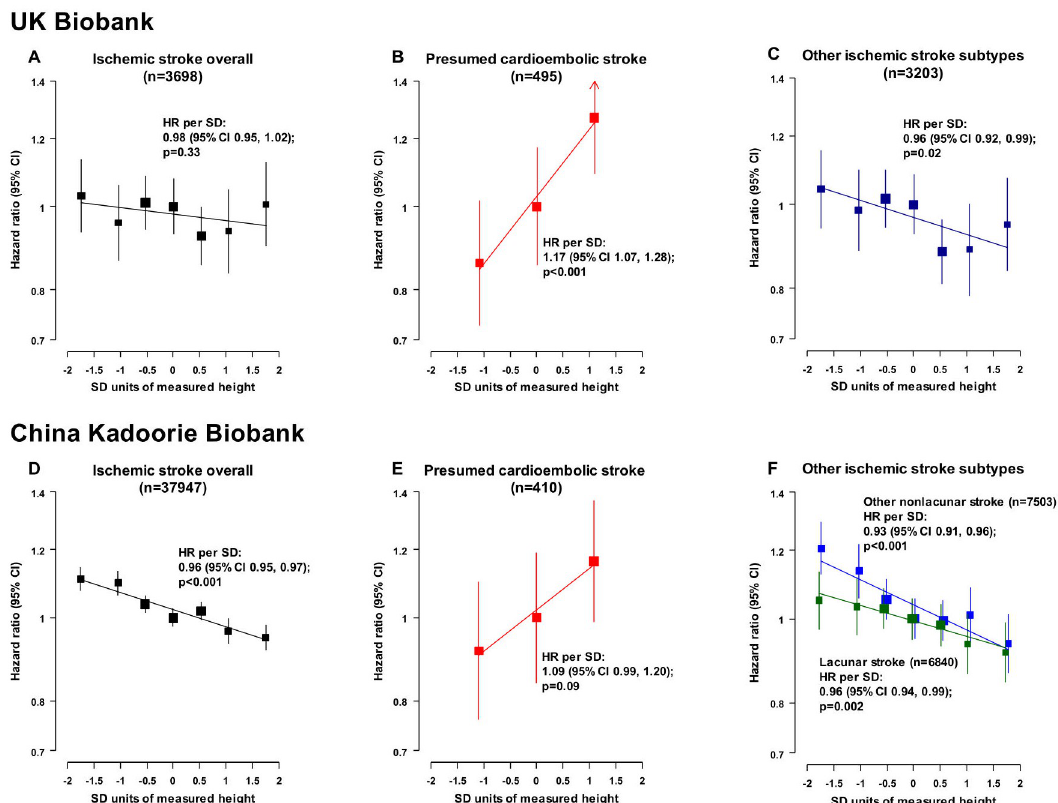
Fig 3. Associations of measured height with ischemic stroke and its subtypes in UKB and CKB. In UKB, the category “Other ischemic stroke subtypes” includes all ischemic strokes not classified as “Presumed cardioembolic stroke,” whereas in CKB, the category includes all subtyped ischemic strokes not classified as “Presumed cardioembolic stroke.” For UKB (482,928 participants) and CKB (490,067 participants), respectively, the SDs of directly measured height were 6.8 cm versus 6.5 cm for men and 6.3 cm versus 6.0 cm for women. HRs were stratified by age at risk (in 5-year groups), sex, and region (in CKB only) and adjusted for additional potential confounders (S6 Methods). Tenths of measured height were used to examine the shape of the associations of height with ischemic stroke subtypes, except for presumed cardioembolic stroke where thirds were used due to the lower number of cases. When tenths of height were plotted, consecutive pairs of the middle 6 tenths were combined (to give 7 groups). HRs were presented as floating absolute risks relative to the middle height category (whereby standard errors were assigned approximately independently to each category to avoid restricting comparisons to any arbitrary reference groups). CI, confidence interval; CKB, China Kadoorie Biobank; HR, hazard ratio; SD, standard deviation; UKB, UK Biobank.